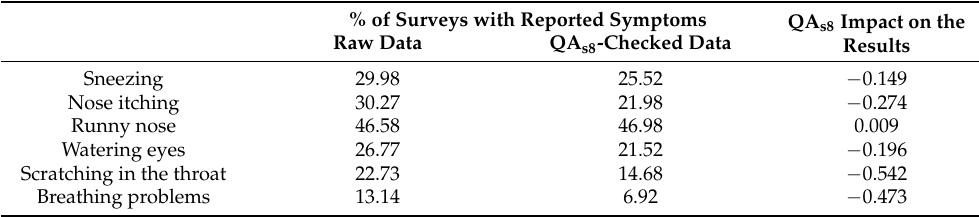
Table 7. QA s8 impact on the percentage of surveys with reported air-pollution-related symptoms. % of Surveys with Reported